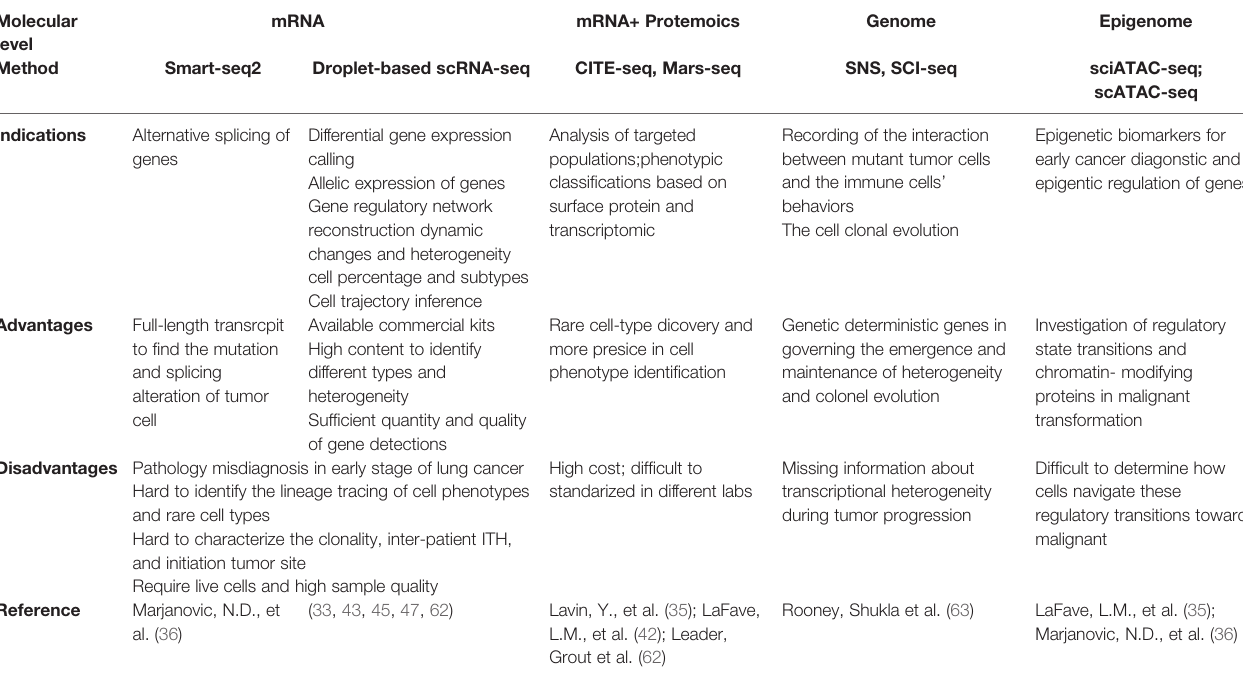
TABLE 2 | Summary of advantages and disadvantages of current single-cell sequencing platforms in studying the evolution of early-stage LUAD. Molecular